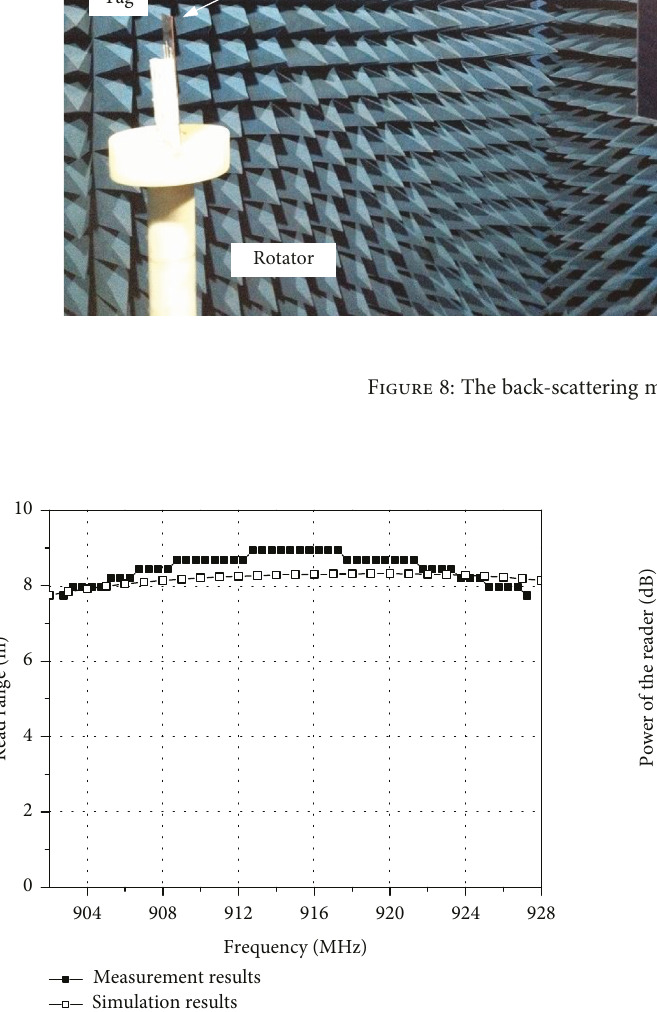
Figure 9: Theoretical and experimental read ranges of di ff erent frequencies for the tag antenna ( EIRP = 4W ) .